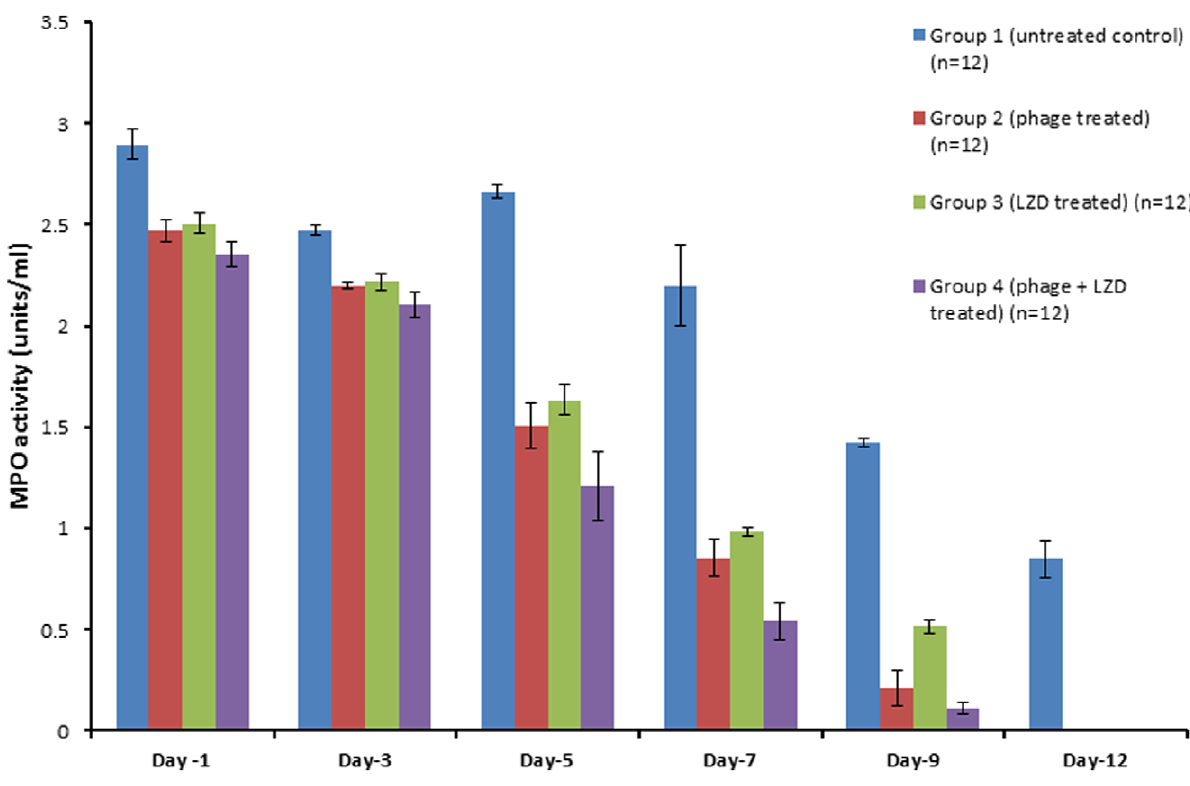
Figure 5. Comparison of MPO levels in the hindpaw of phage MR-10, linezolid and combination of both treated diabetic BALB/c mice at different time intervals. [Error bars represent the standard deviation (S.D) from four independent